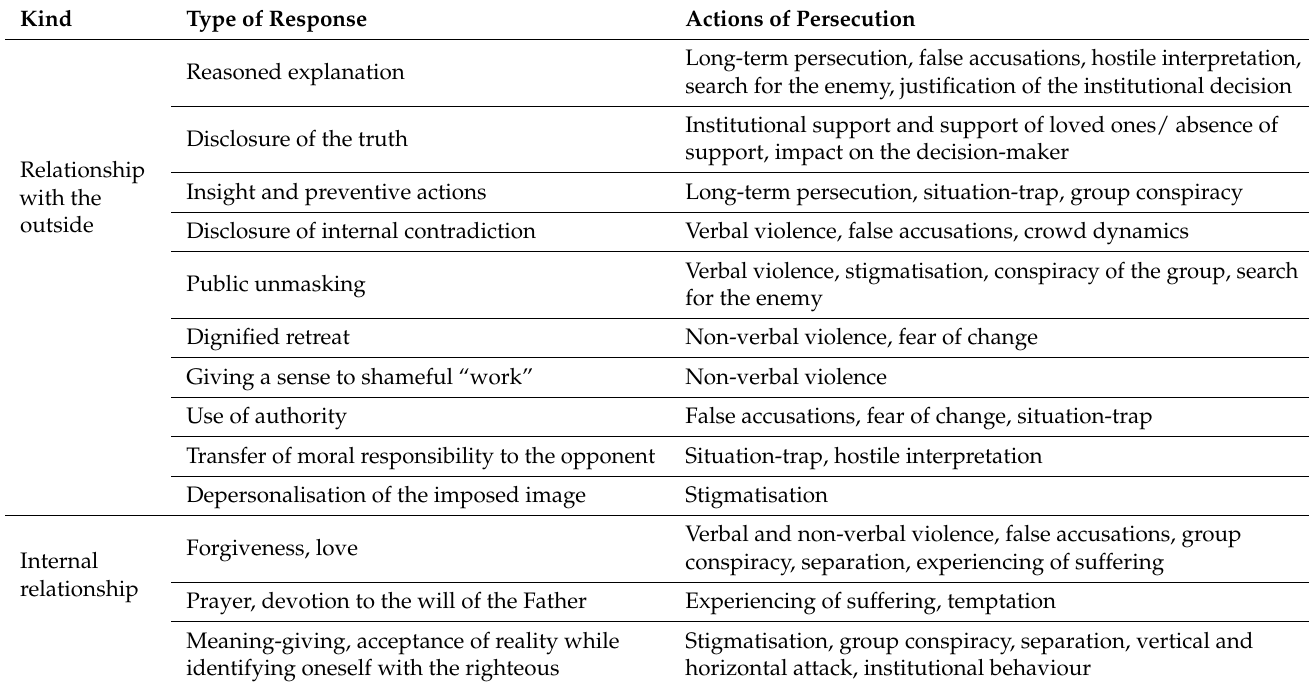
Table 8. The typical response to persecution actions in the Gospel of